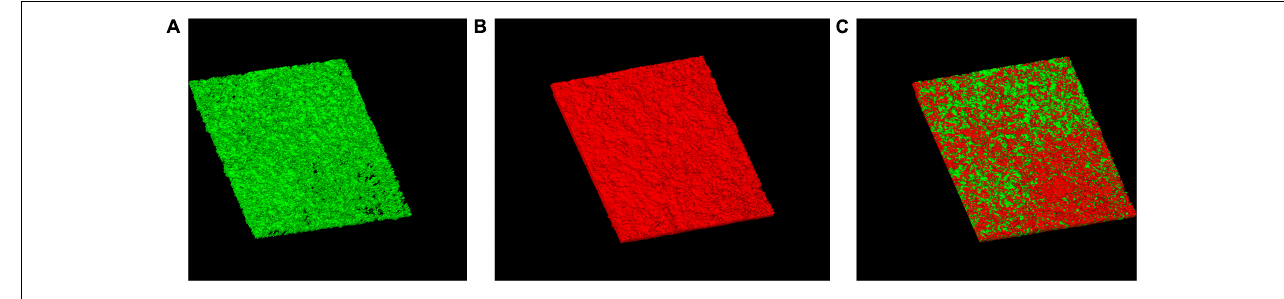
FIGURE 3 | Penetration of CSNPs into biofilms. CSNPs were labeled with rhodamine B isothiocyanate (RBITC) and visualized by confocal laser scanning microscopy (CLSM). SYTO 9-labeled biofilms incubated with CSNPs (A) . RBITC-NP penetration into biofilms (B) . Overlap (C) .